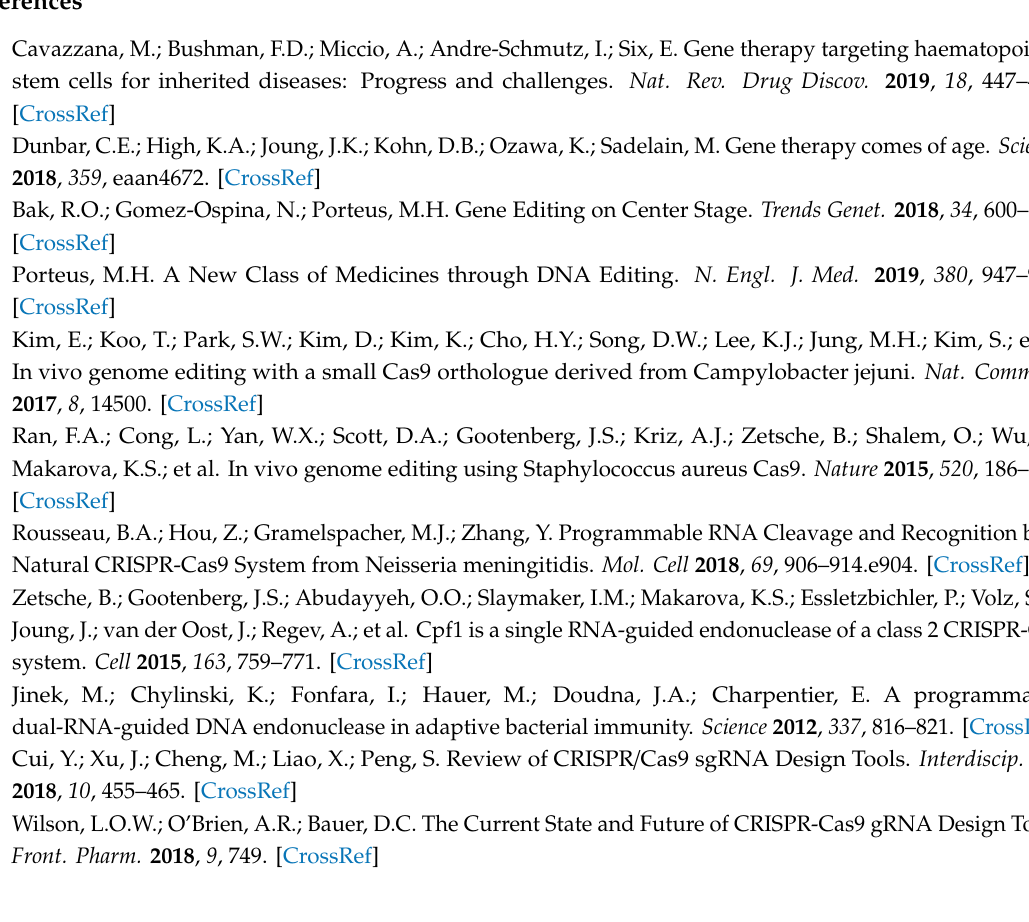
Table S1: Indel calls; Table S2: SNV calls; Table S3: Homologous CXCR4 sites; Table S4: Homologous AAVS1 sites; Table S5: Called